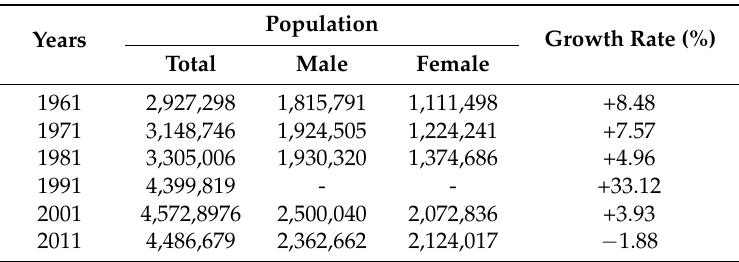
Table 3. Population data of Kolkata Municipal Corporation area (KMC) from 1971 to 2011 according to the Census of India